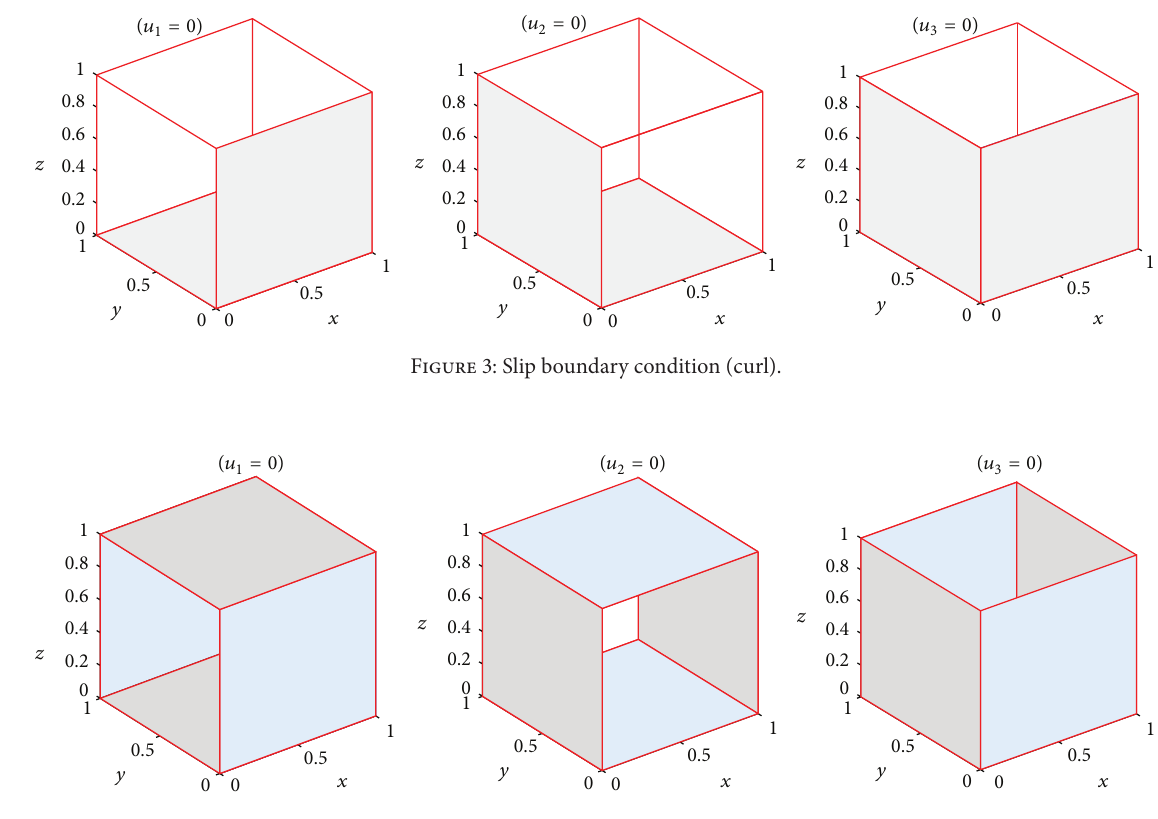
Figure 4: Free-slip boundary condition